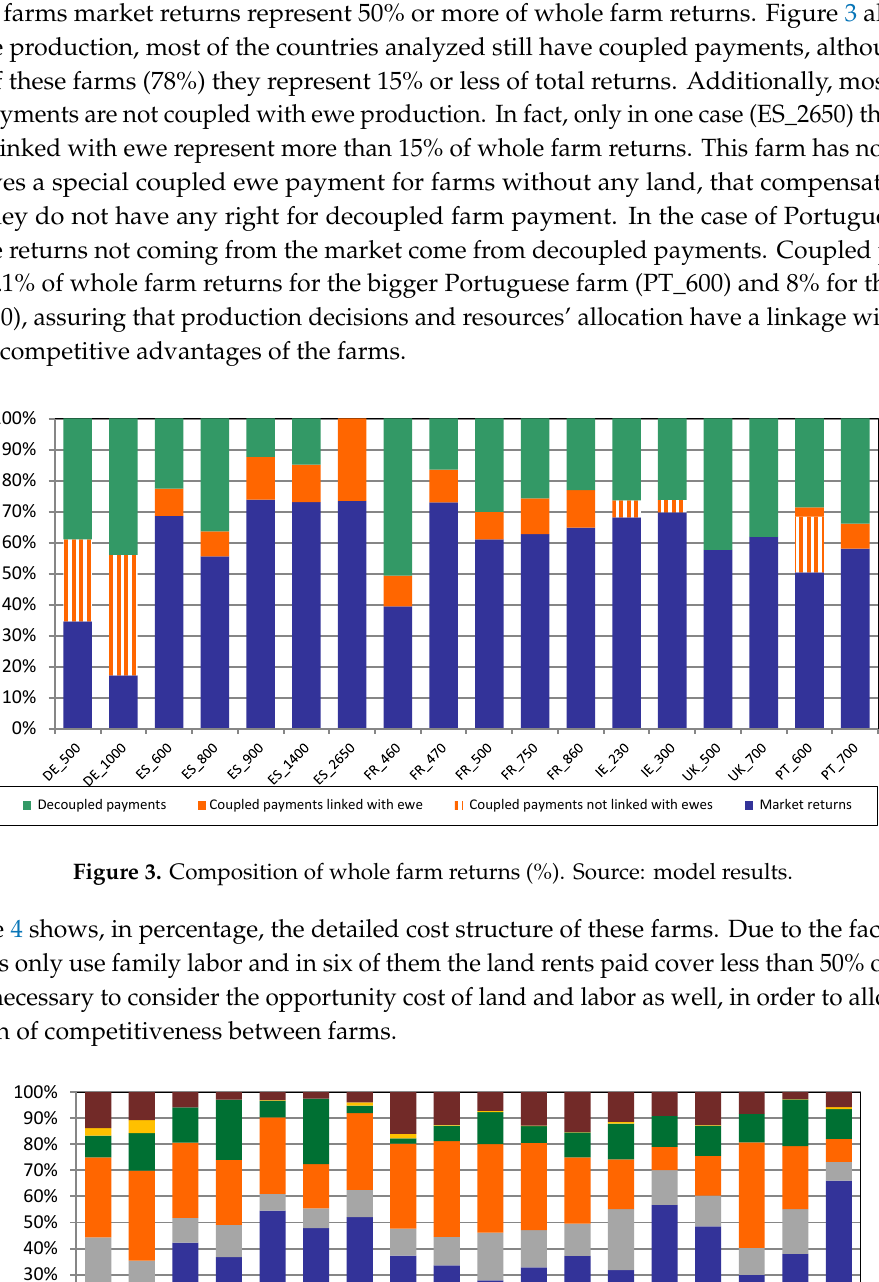
Figure 2. Return structure (% of different farm activities on the farm returns). Source: model results.